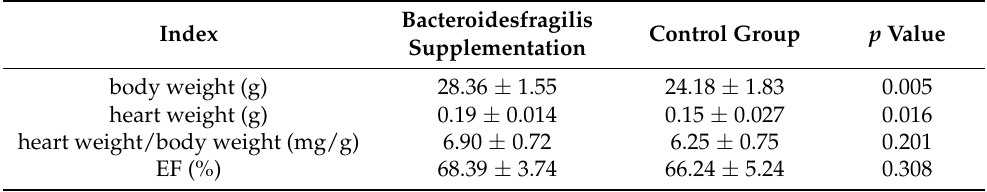
Table 3. Effects of bacteroides fragilis supplementation on body weight, heart weight and ejection fraction in